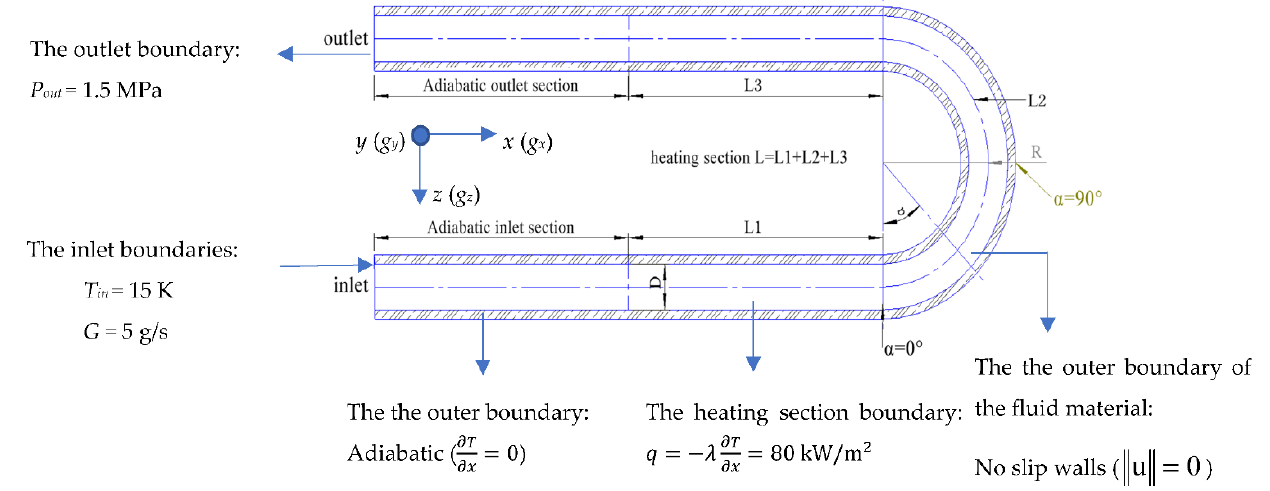
Figure 1. U-type tube model.